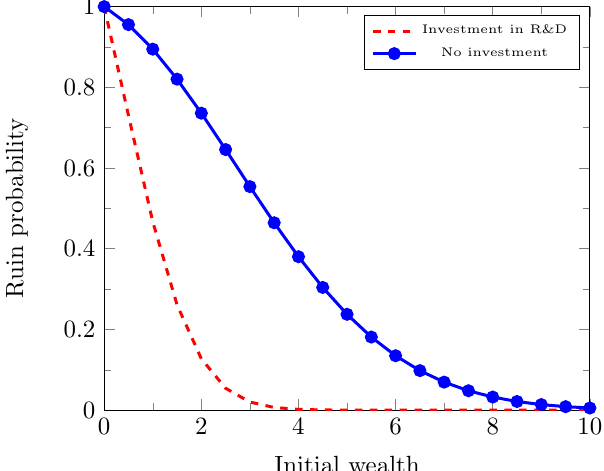
Figure 4. Illustration of the ruin probability without any investment (blue curve with circle markers), the minimized ruin probability with investment in research and development (red dashed curve). The x -axis denotes the initial wealth of the underlying company and the y -axis denotes the (minimized) ruin probability. Here, we take γ = 0.5, ρ 0 = 1, ν = 0.1, λ 0 = 0.1, δ = 1, c 1 = 1 and c 2 =